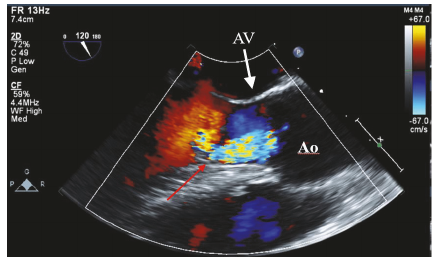
Figure 2: Transesophageal echocardiogram mid-esophageal posi- tion demonstrating a 1.3 by 1.0 cm mass (red arrow) attached to the interventricular septum in the left ventricular outflow tract during diastole. LVOT = left ventricular outflow tract, Ao = aorta, and AV = aortic valve.